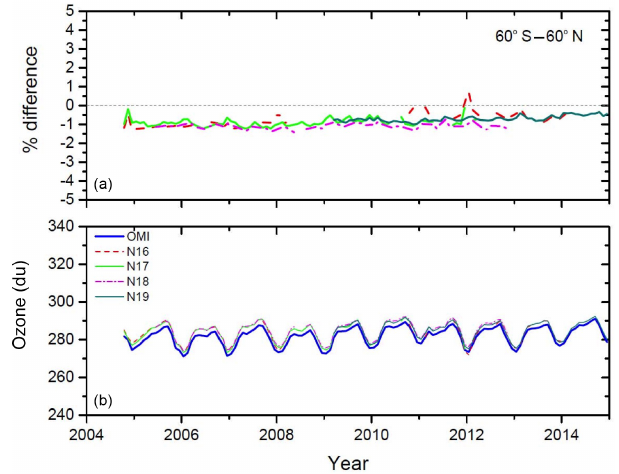
Figure 11. Total column ozone from OMI and four NOAA SBUV instruments (b) and differences in percent of OMI minus each SBUV instrument ( a ; adapted from McPeters et al.,